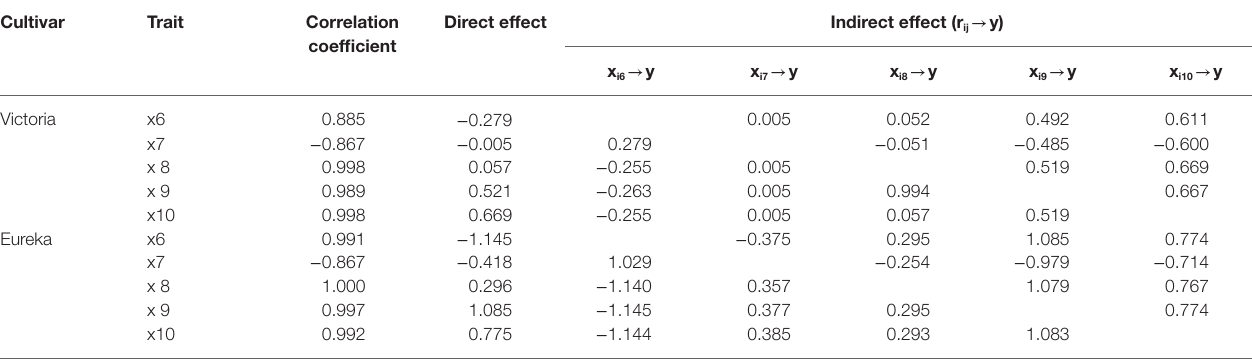
TABLE 5 | Path analysis of seed yield per plant and fruiting factors of two alfalfa cultivars. Cultivar Trait Correlation Direct effect Indirect effect (r ij → coefficient